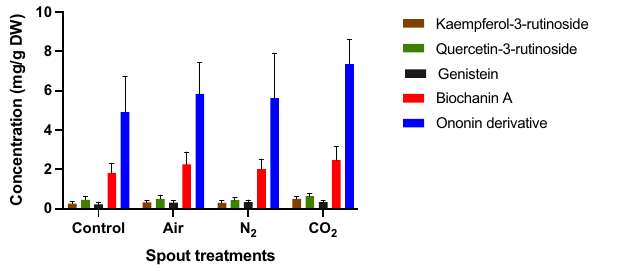
Figure 6. Impact of different plasma treatments on the secondary metabolites of sprouts expressed in dry weight